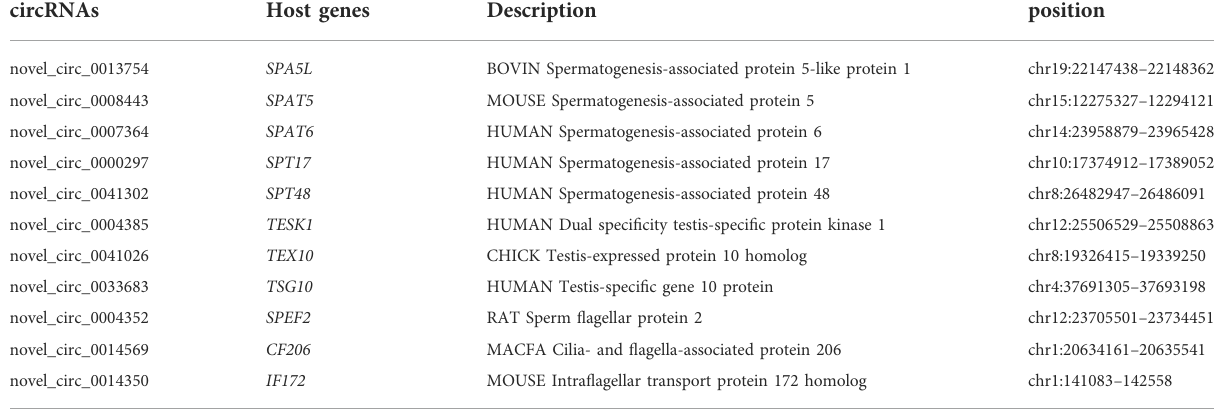
TABLE 3 Annotation of host genes associated with gander reproduction for partial circRNAs.